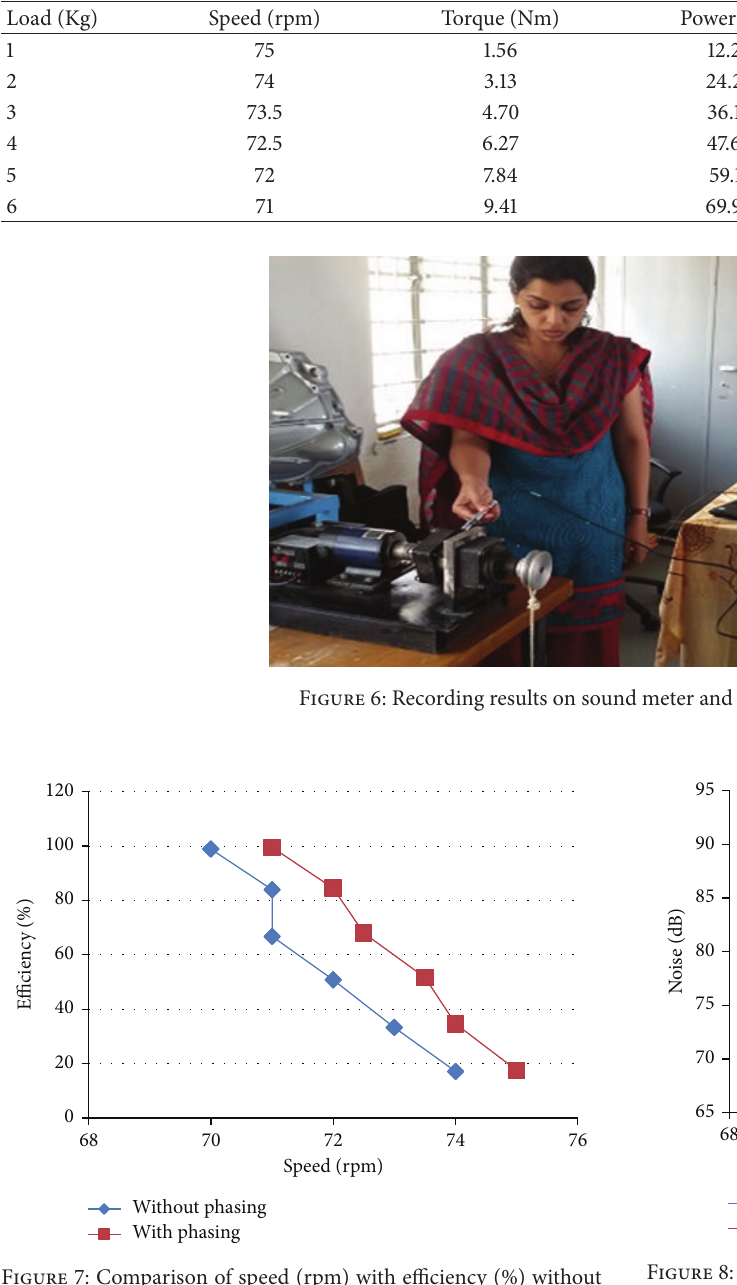
Figure 7: Comparison of speed (rpm) with efficiency (%) without and with phasing.